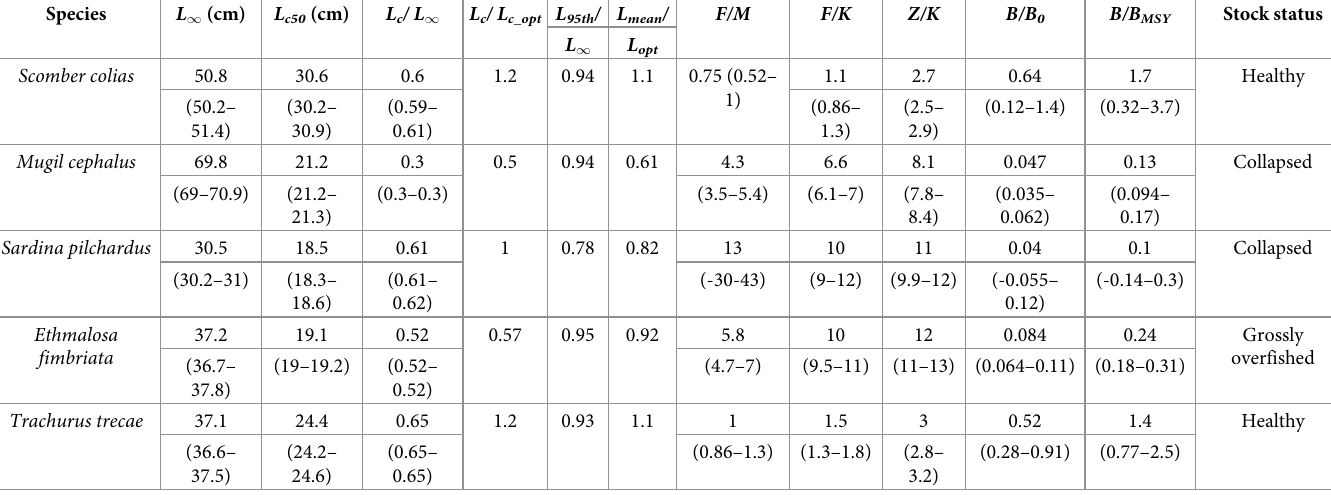
L 1 : L t value when the growth rate is zero; L c50 : length at first capture L c where 50% of the individuals are retained by the gear; L c / L 1 : relative length at first capture; L 95th /L 1 is the 95th percentile length to asymptotic length; L mean /L opt : current size and age composition of health state; F/M : relative fishing mortality; F/K : fishing mortality rate ( F ) to somatic growth rate; Z /K is the ratio of the total mortality rate Z to somatic growth rate; B/B the ratio of observed biomass, B , to the biomass that would provide maximum sustainable yield, B